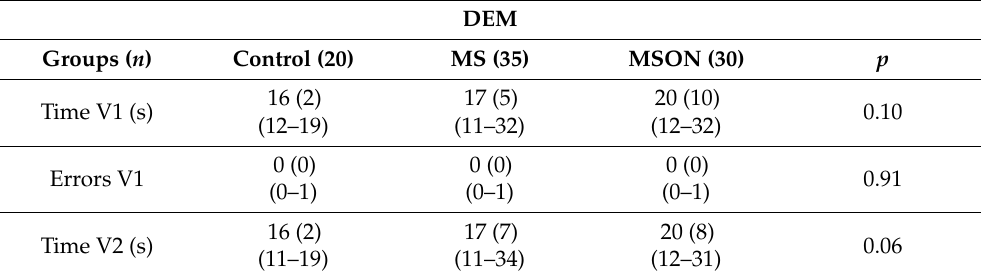
Table 3. Median (and interquartile range) of the three study groups for DEM test. Minimum and maximum were represented in square brackets. Statistically significant differences were marked with an asterisk (*).